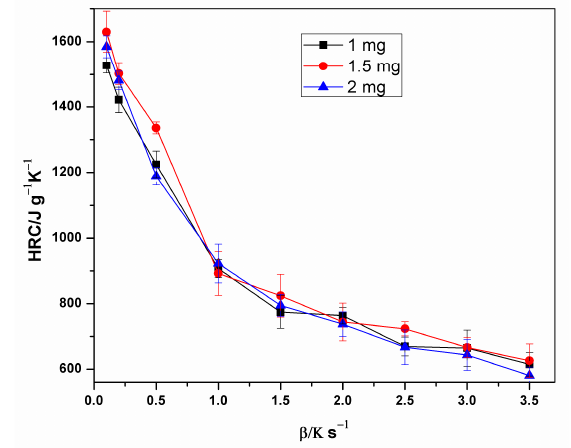
Figure 3. Plot of Heat Release Capacity versus heating rate for different sample masses.